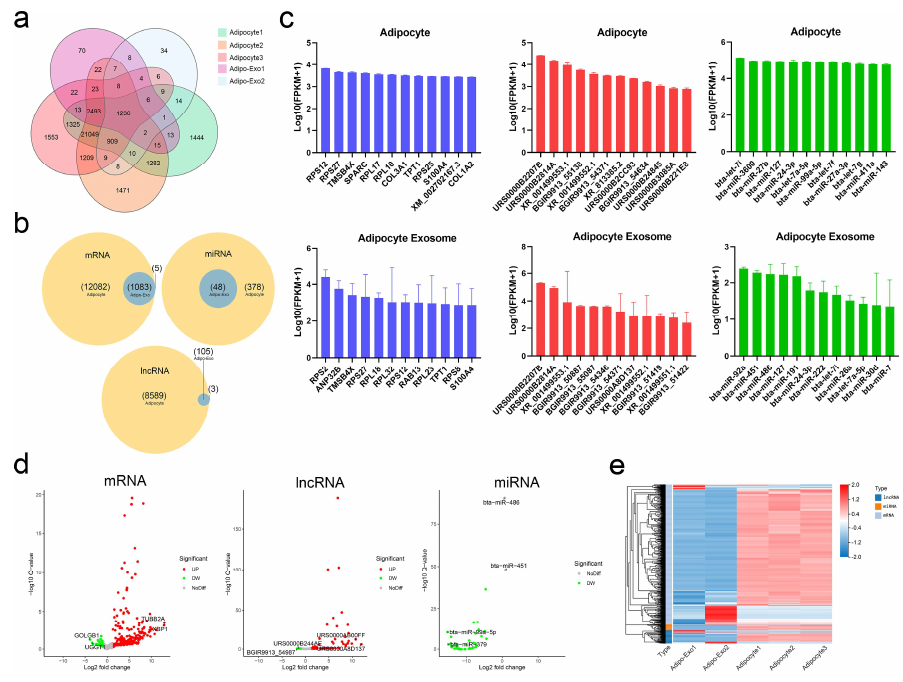
Figure 3. Profiles of exosomal and nonexosomal RNAs. ( a , b ) Venn diagrams showing the profile of total RNAs ( a ) and three types of RNA ( b ) overlaps between adipocytes and released exosomes. ( c ) Histograms of the 12 most abundant mRNAs (blue), lncRNAs (red), and miRNAs (green) from adipocytes and released exosomes. ( d ) Volcano maps of di ff erentially expressed exosomal mRNAs, lncRNAs, and miRNAs according to the criteria of fold change ≥ 2 between parental adipocytes and exosomes. ( e ) Heatmap of di ff erentially expressed RNAs between parental adipocytes and